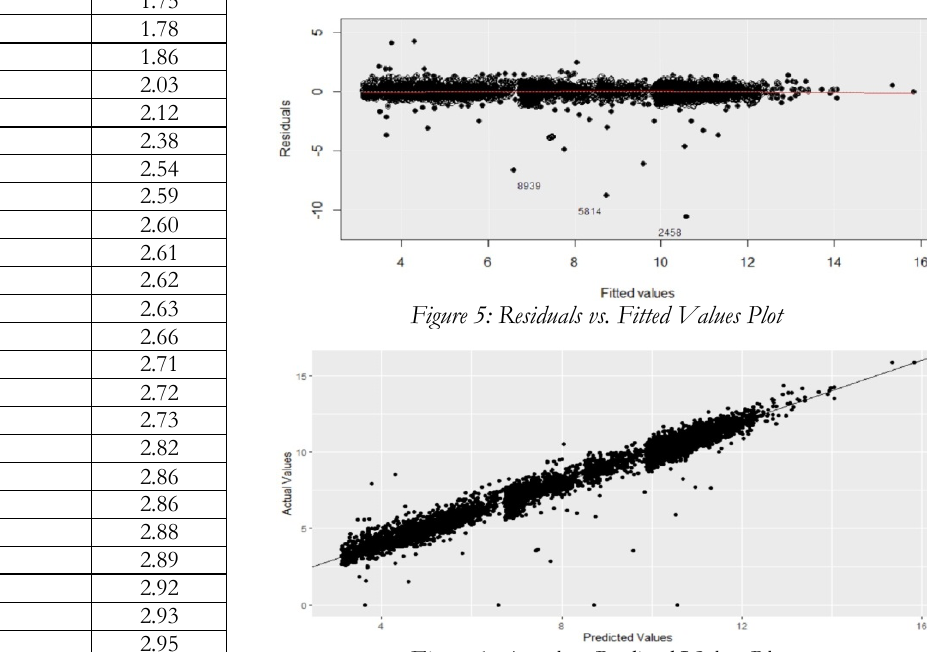
Figure 6: Actual vs. Predicted Values